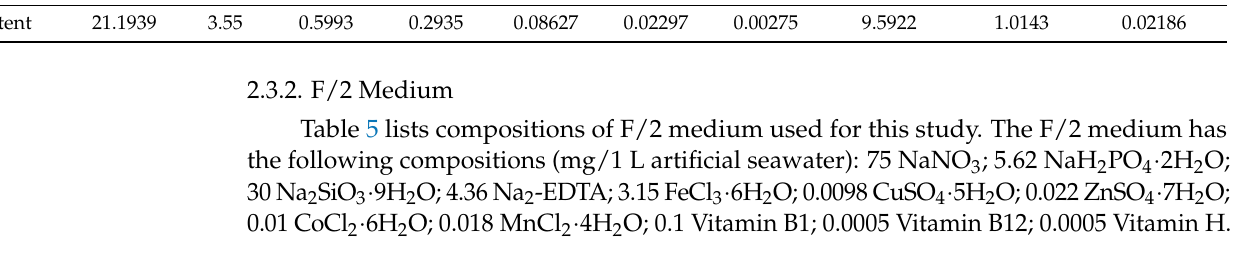
Table 4. Compositions of artificial seawater used for this study, (g/1 L ultrapure water). Compositions